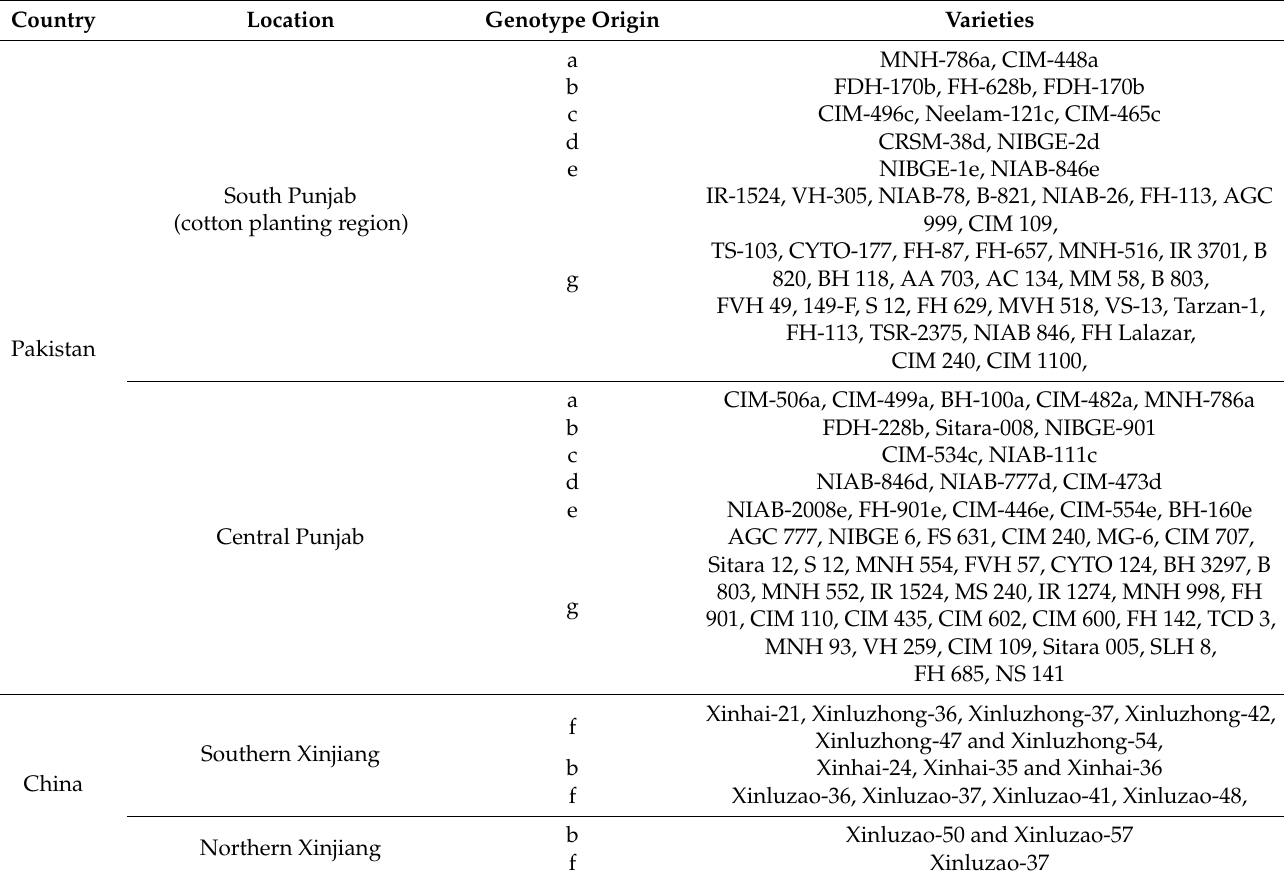
Table 1. Comparison list of progressive, heat-tolerant, medium to short-duration, film mulching, local and international, cotton varieties of China (South and North Xinjiang), and Pakistan (Central and South Punjab) in cotton planting region.